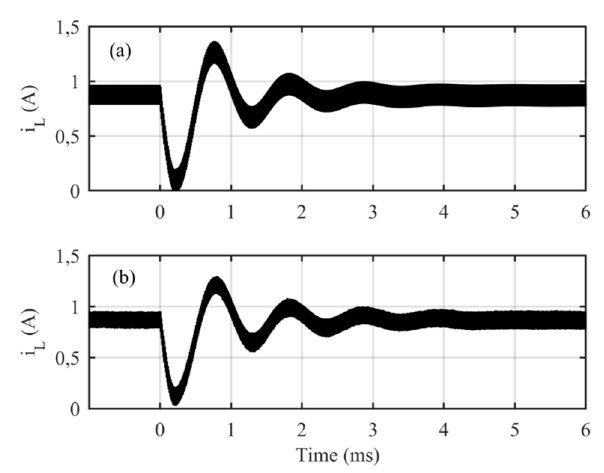
Figure 12. The comparison if the behavior of inductor currents in CCR when the maximum step size (i.e., 0.075) is applied: ( a ) Simulated behavior, and ( b ) experimentally measured behavior.